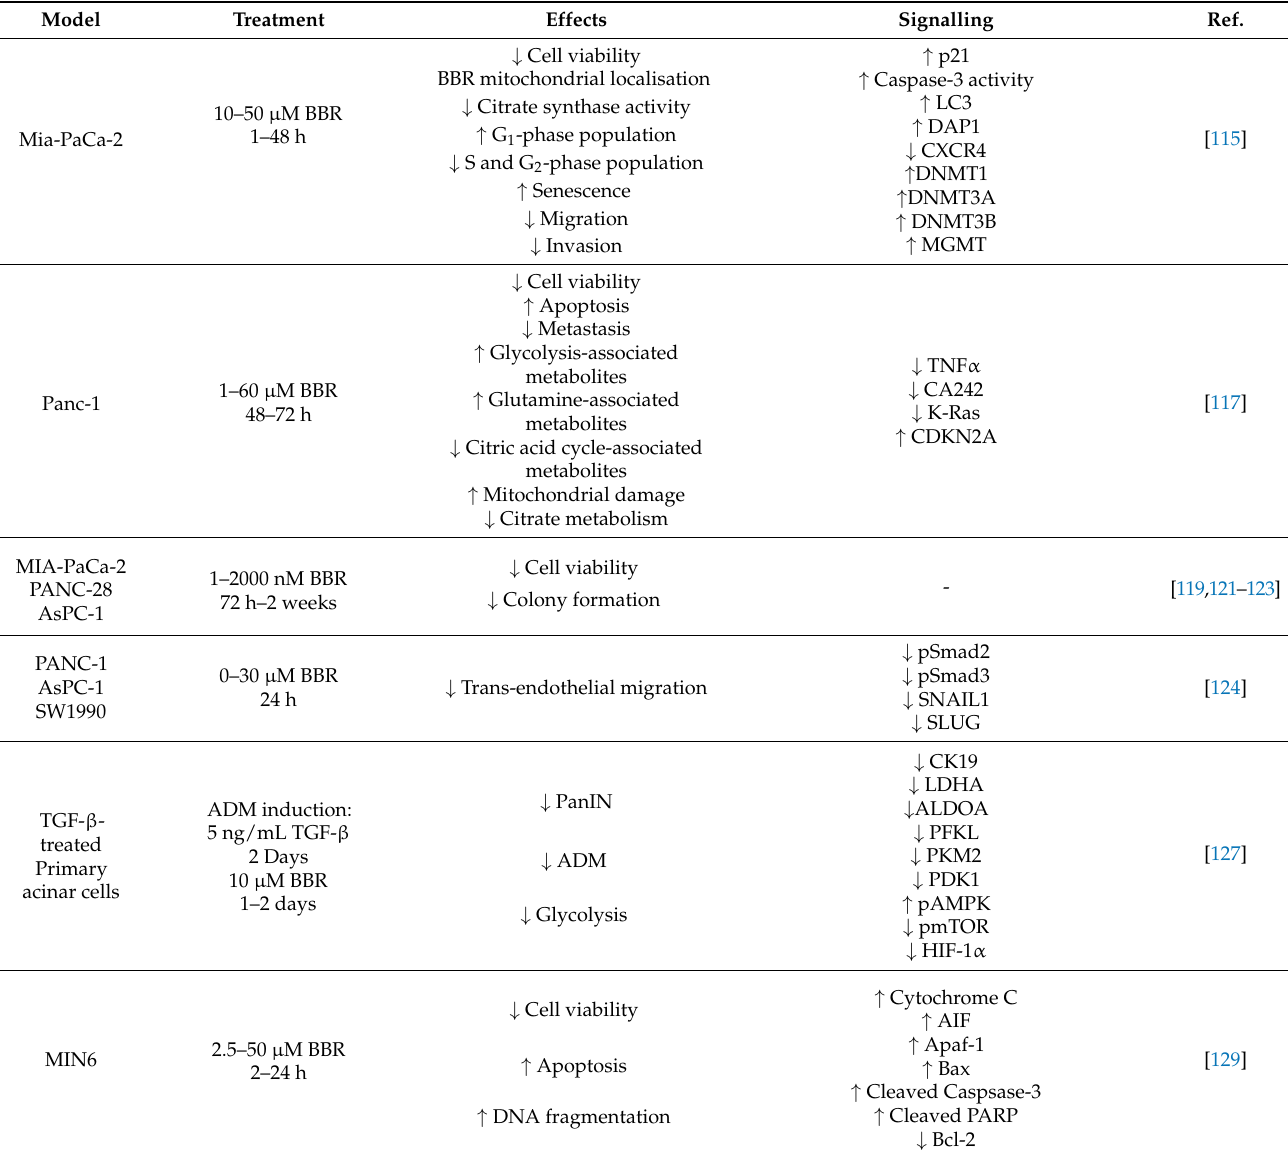
Table legend: ↑ increases, ↓